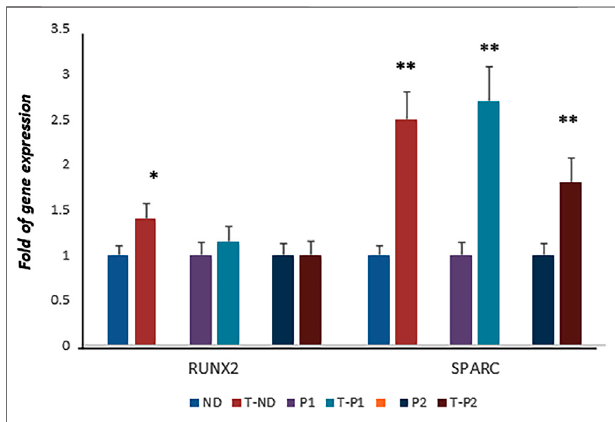
FIGURE 6 | RUNX2 expression was not affected by fi setin in CCD patients. However, fi setin supplementation strongly upregulated the expression of SPARC in control as well as in osteogenic differentiating cells of both RUNX2 mutant patients (normal control vs treated normal control, untreated patients ’ cells vs treated patients ’ cells respectively)) (D). p < 0.05; ** p < 0.005.ND,NormalDonor;T-ND,TreatedNormalDonor;P1,Patient1;T-P1, Treated Patient 1; P2, Patient 2; T-P2, Treated Patient 2.